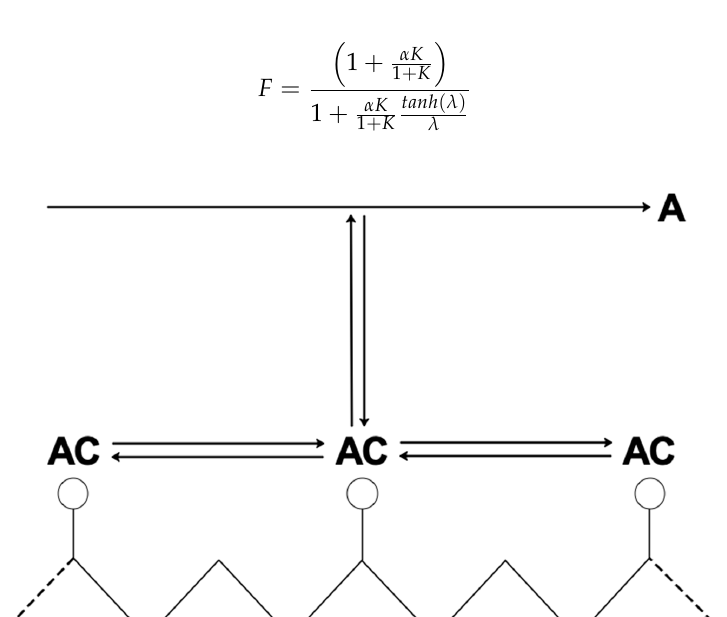
Figure 12. Solute transport pathways in fixed sites carrier systems used by Noble [109].